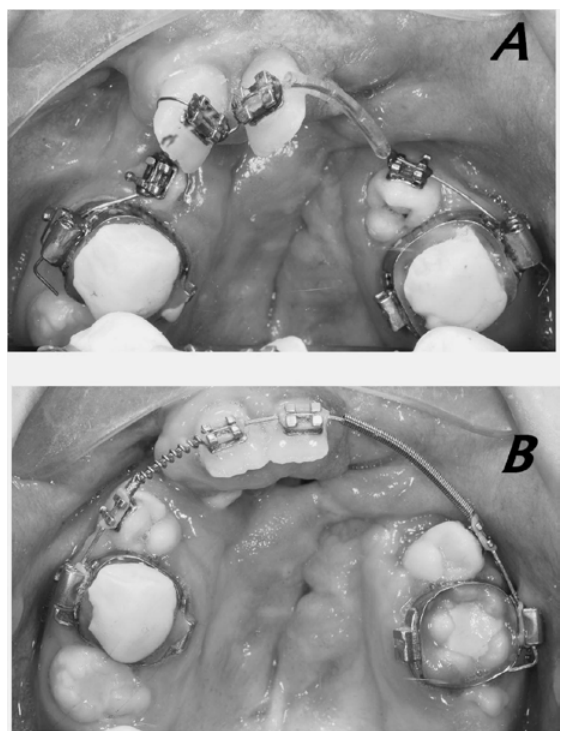
Figure 3. A - Before preliminary arrangement of the teeth in the maxilla and its expansion with fixed orthodontic appliances; B - after first phase of orthodontics